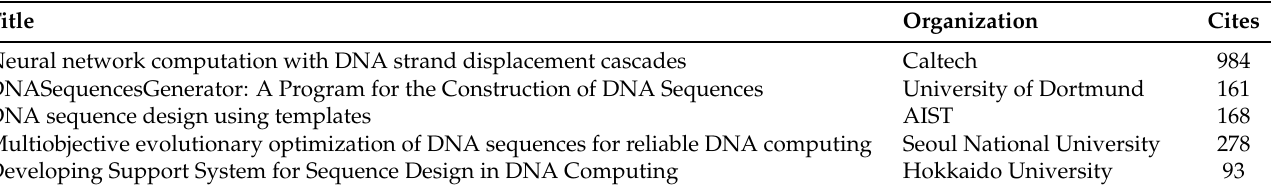
Table 5. Representative papers in the field of biological computing.